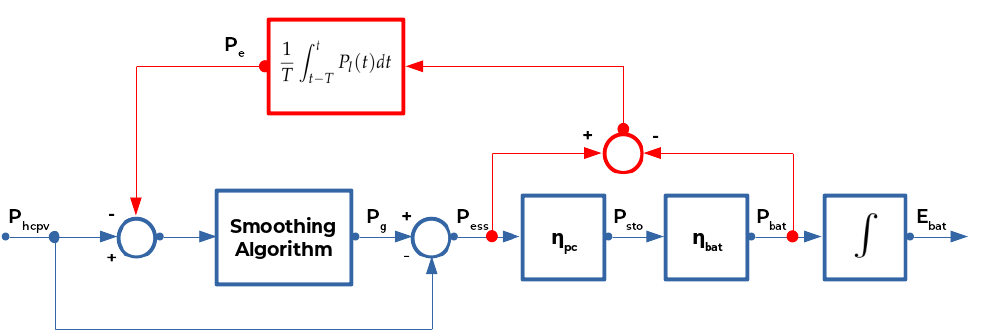
Figure 6. Block scheme of the moving average algorithm. The branch associated with the feedback is in red.